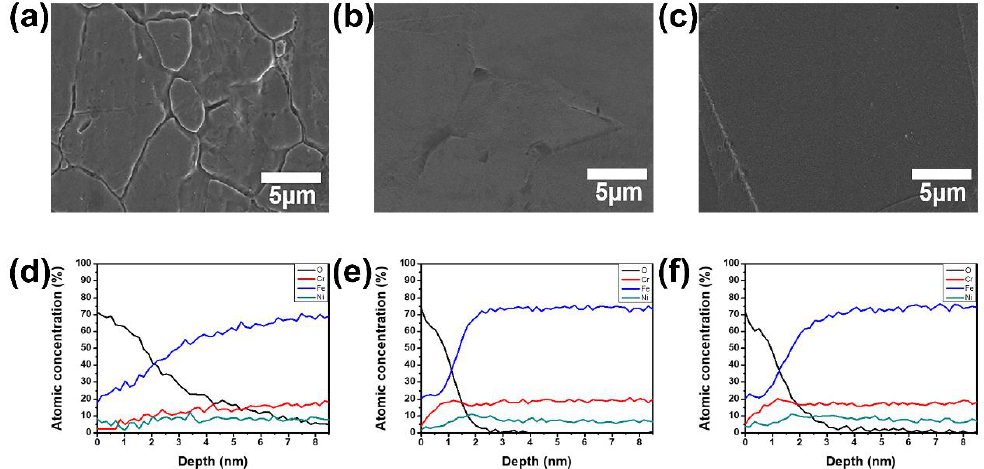
Figure 3. Microstructure and chemical composition of 304 stainless steel after electropolishing. ( a ) SEM image of pristine 304 stainless steel and stainless steel after ( b ) electropolishing at the Cu electrode and ( c ) M-GNP electrode. Auger depth profiling analysis of ( d ) pristine 304 stainless steel and stainless steel after ( e ) electropolishing at the Cu electrode and ( f ) M-GNP electrode.